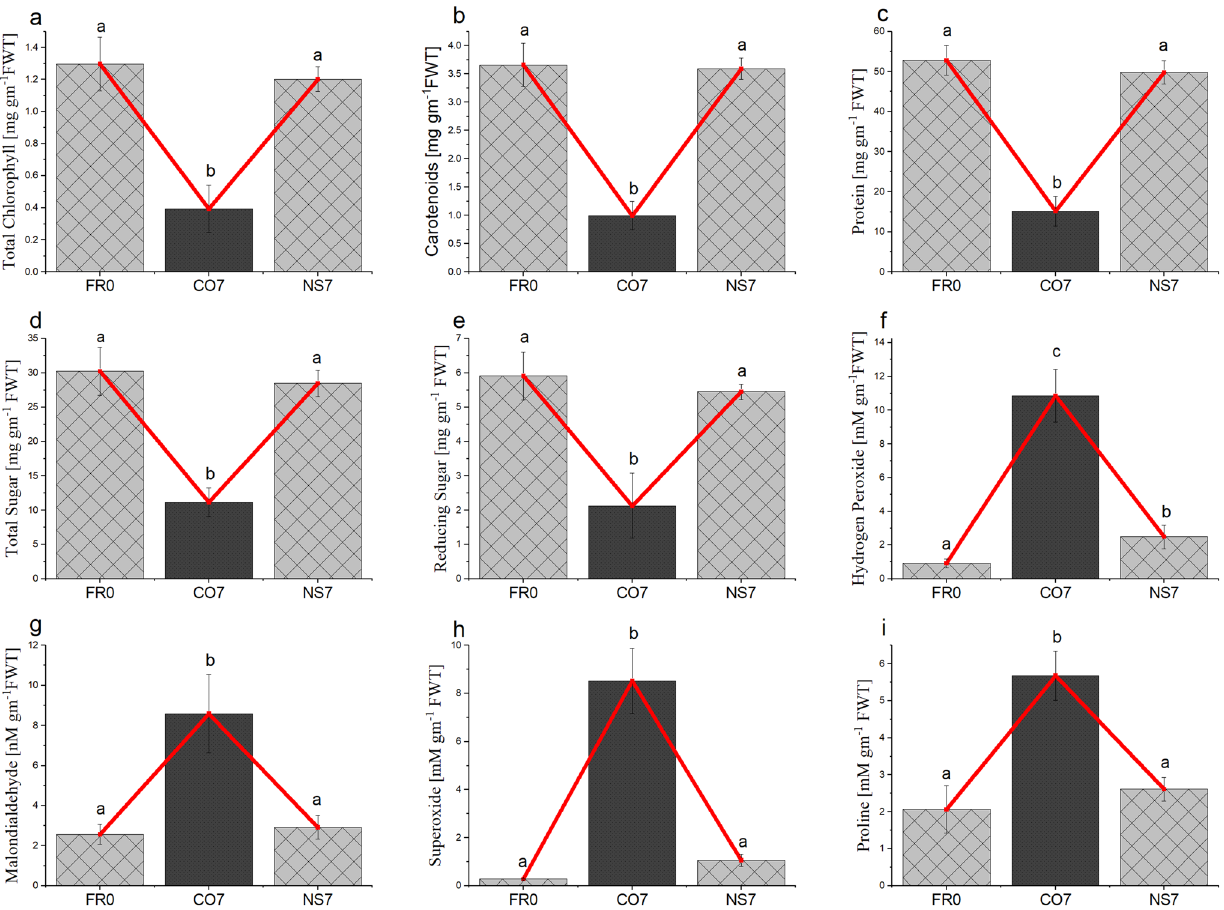
Figure 2. Comparative evaluation of ( A ) total chlorophyll, ( B ) carotenoids, ( C ) total protein, ( D , E ) total and reducing sugar, ( F ) hydrogen peroxide, ( G ) Malondialdehyde, ( H ) superoxide and ( I ) proline content between 7 day preserved leaves in distilled water (CO7) and nanosilver solution (NS7) with respect to fresh leaves (FR0). The results were expressed as Mean ± SDEV, n = 3. Values with different letters (a, b, c, etc.) differ significantly ( p ≤ 0.05) by Duncan’s Multiple Range Test (DMRT).